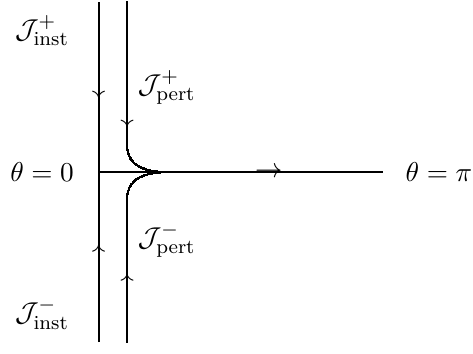
Figure 15 . The steepest descent contours for the action